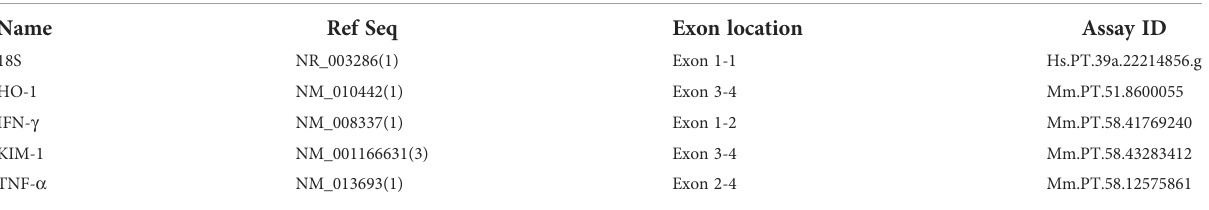
TABLE 1 List of primers used for